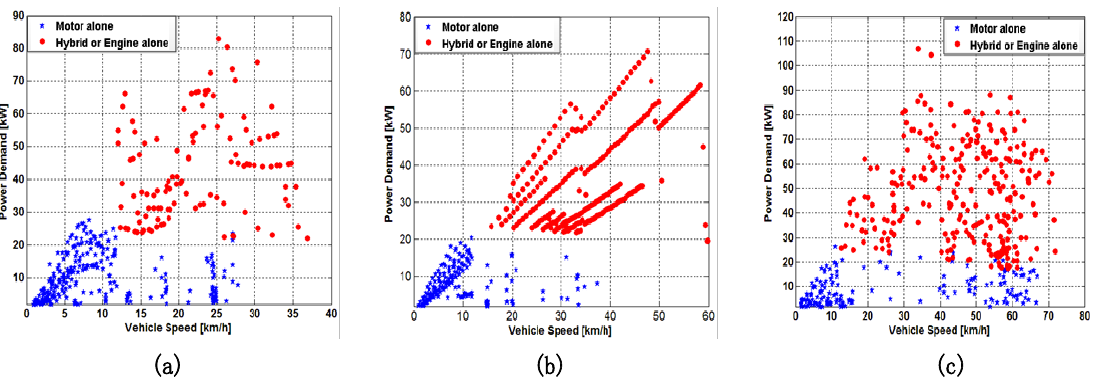
Figure 9. The distribution of operating points of engine and motor in three driving cycle conditions. ( a ) Manhattan; ( b )China typical; ( c ) WVUSUB.